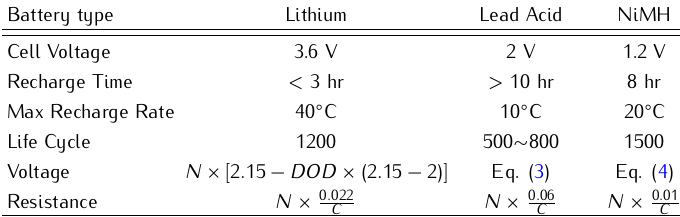
Table 1. Battery specifications.